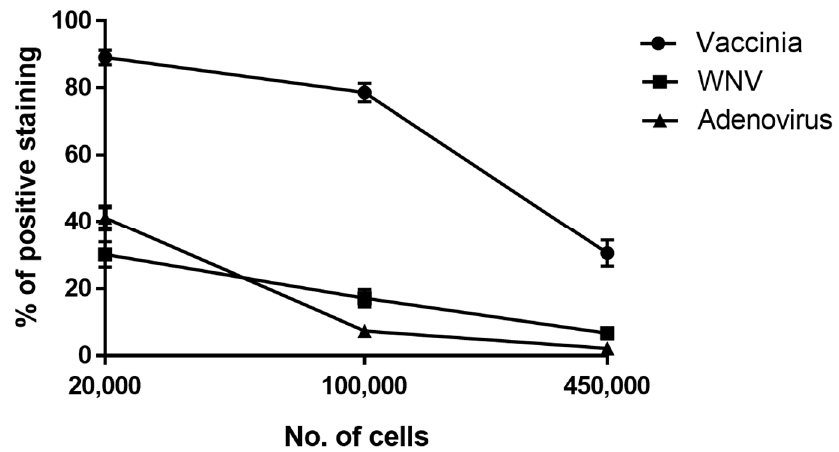
Figure 2. Optimization of cell number used for the cell-based immuno-assay in flow cytometry. The cells were harvested and diluted to achieve 20,000, 100,000 and 450,000 cells per tube. WNV were added at 9 × 10 6 pfu / mL, MVA and Adenovirus were added at 1e6 pfu / mL for one hour with shaking at 4 ◦ C to allow attachment. The cells were then immuno-labeled with the relevant fluorescent antibody and analyzed in FACS. The results shown represent average values of positive staining ± SEM from 3 independent experiments in biological duplicates for each of the viruses.